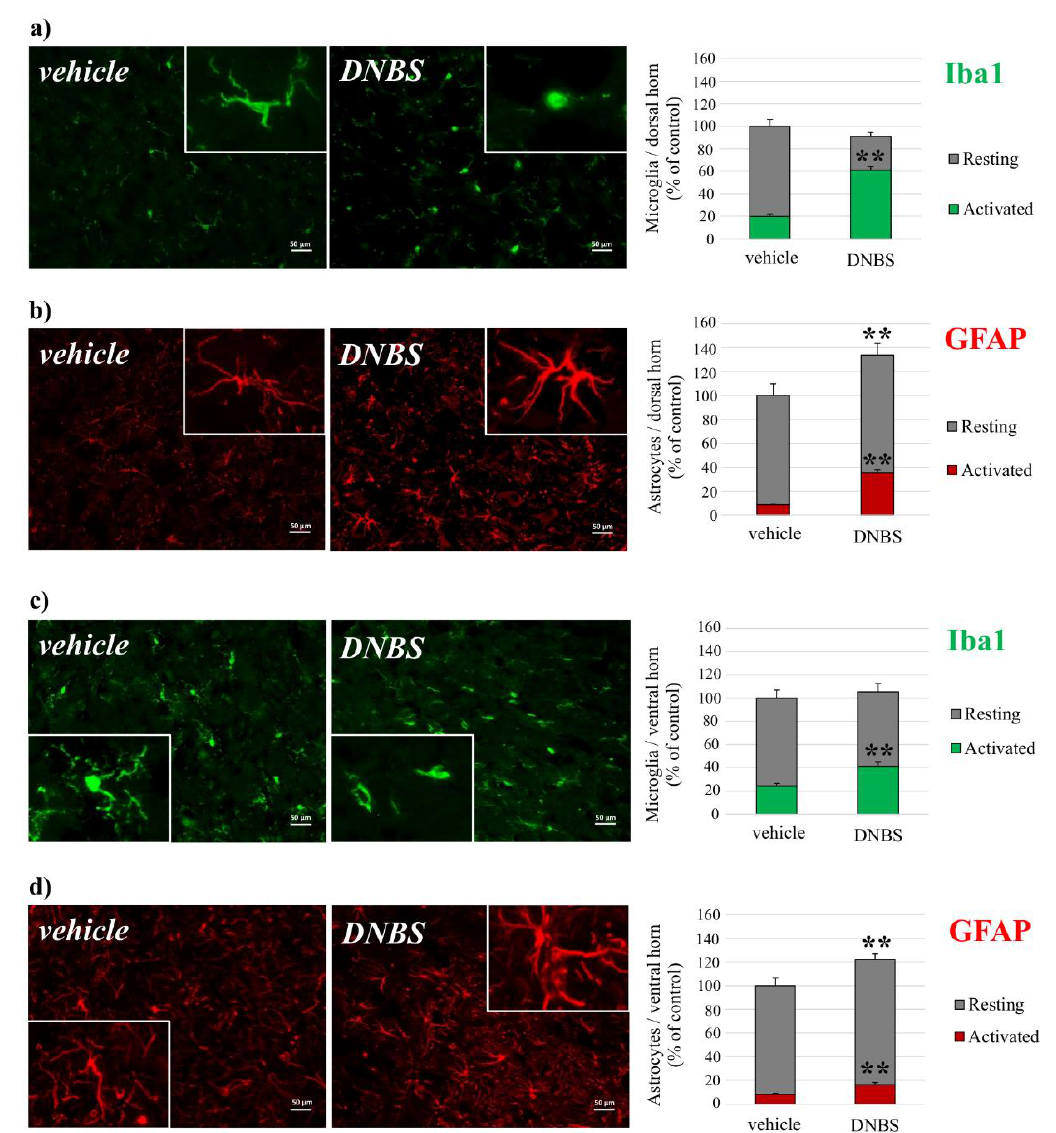
Figure 7. Evaluation of microglia and astrocytes activation in spinal cord horns. Iba1-positive cell density in the ( a ) dorsal and ( c ) ventral horns of the spinal cord 14 days after DNBS injection. Representative images of merged Iba1-labeled microglia cells (green), scale bar: 50 µ m; GFAP-positive cell density in the ( b ) dorsal and ( d ) ventral horn of the spinal cords 14 days after DNBS injection. Representative images of merged GFAP-labeled astrocyte cells (red), scale bar: 50 µ m. Each value represents the mean of 5 rats, performed by analyzing 8 independent fields for both the sides of the spinal cord. ** p < 0.01 vs. control animals.